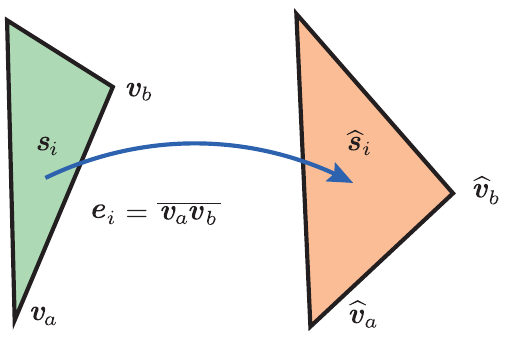
Fig. 4 Illustration for the